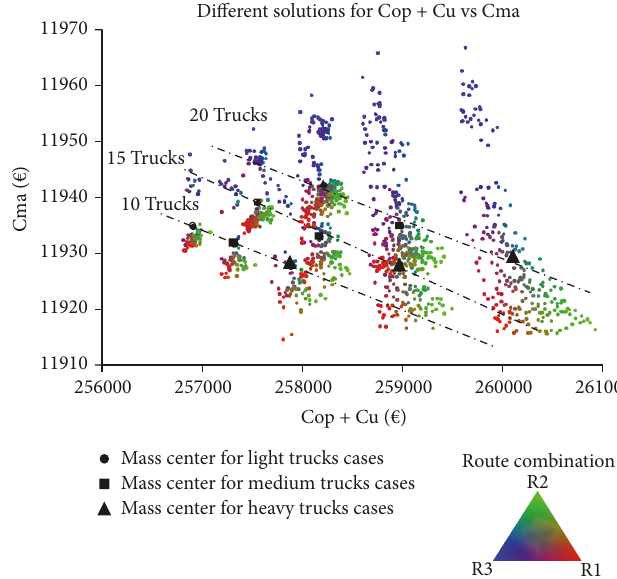
Figure 3: Different solutions for Cop + Cu versus Cma.